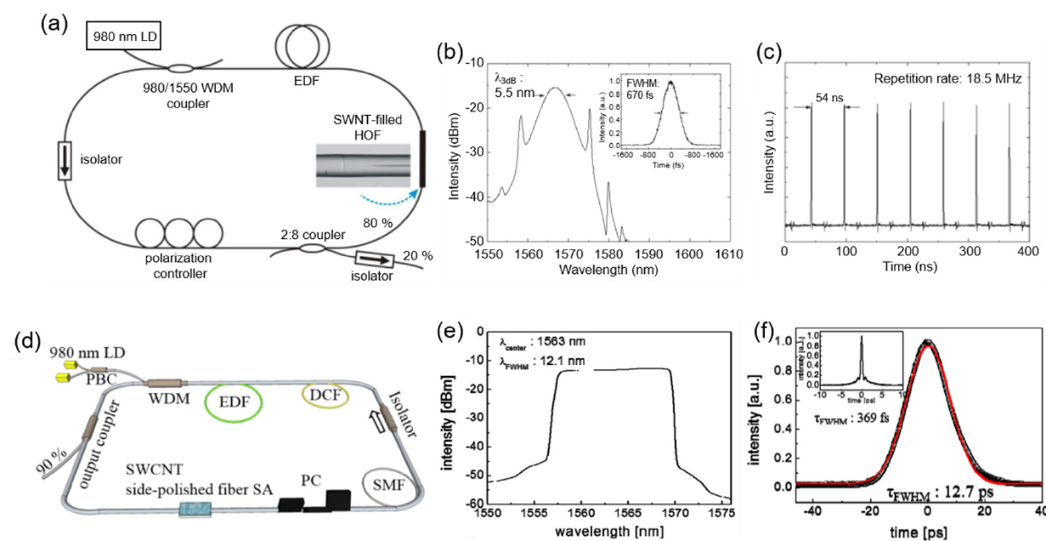
Figure 7. 1D SWCNT SA-based mode-locked fiber laser: ( a – c ) Conventional soliton: ( a ) Schematic of the fs fiber laser using the SWCNT-filled HOF. The inset figure shows the spliced image between the normal SMF and HOF, where adiabatic mode transition occurs. ( b ) Measured optical spectrum and pulse duration (inset) of the mode-locked fiber laser. ( a – c ) Reproduced with permission [188]. Copyright 2009, The Optical Society of America. ( c ) The output pulse train of the laser shows a repetition rate of 18.5 MHz. ( d – f ) Dissipative soliton: ( d ) Configuration of the fiber ring laser including the SWCNT-SA and the DCF. ( e ) The optical spectrum of the mode-locked laser at net cavity dispersion of 0.087 ps 2 and ( f ) Measured pulsed duration fitted with Gaussian pulse. The inset shows the pulse compressed by additional SMF at extra-cavity. ( d – f ) Reproduced with permission [60]. Copyright 2014, The Optical Society of America.